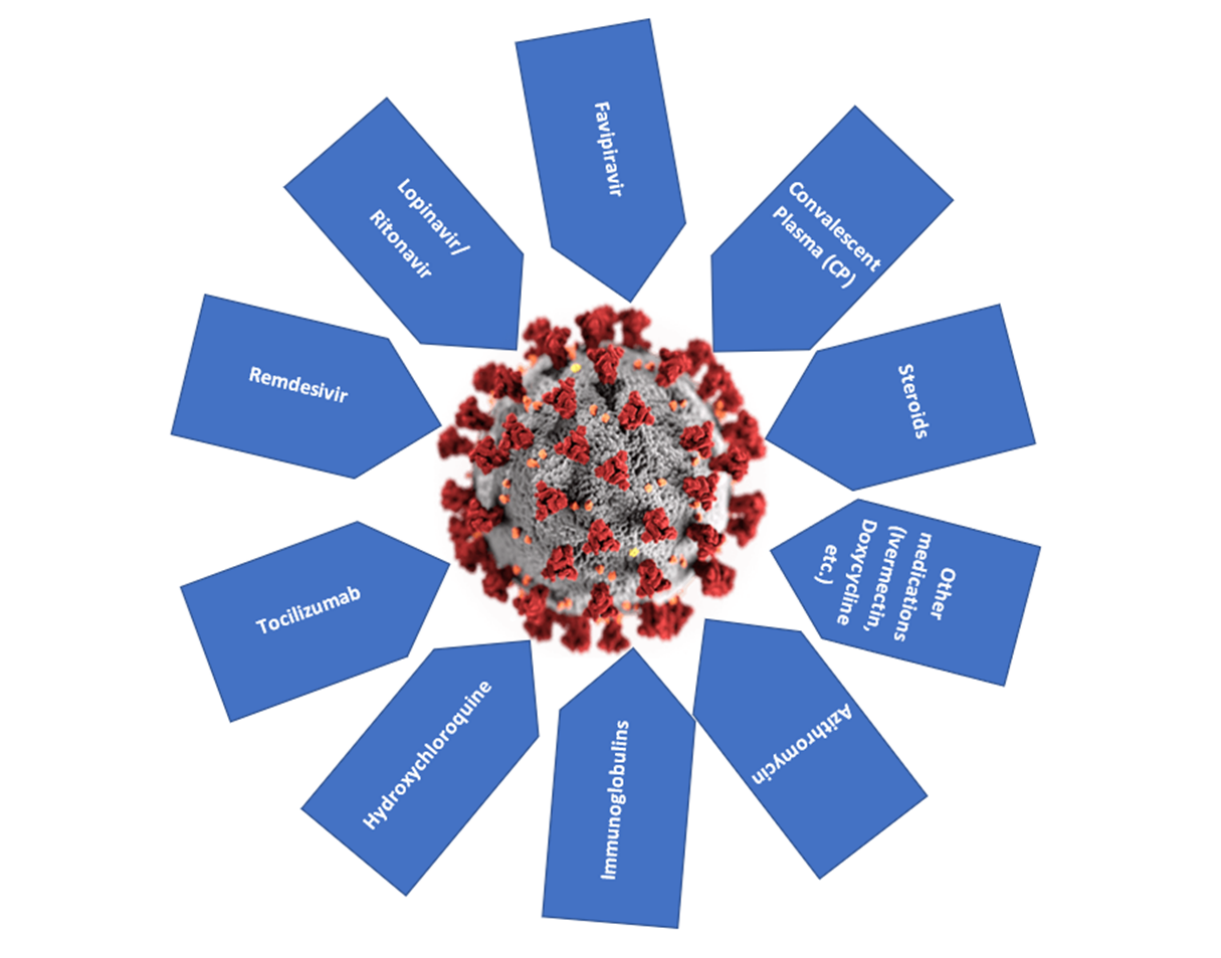
Figure 1. Some therapeutic options for treating